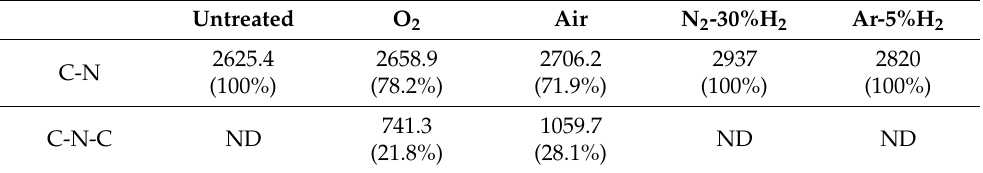
Table 5. Intensity ratios of signals in the XPS N 1s narrow spectra (ND: